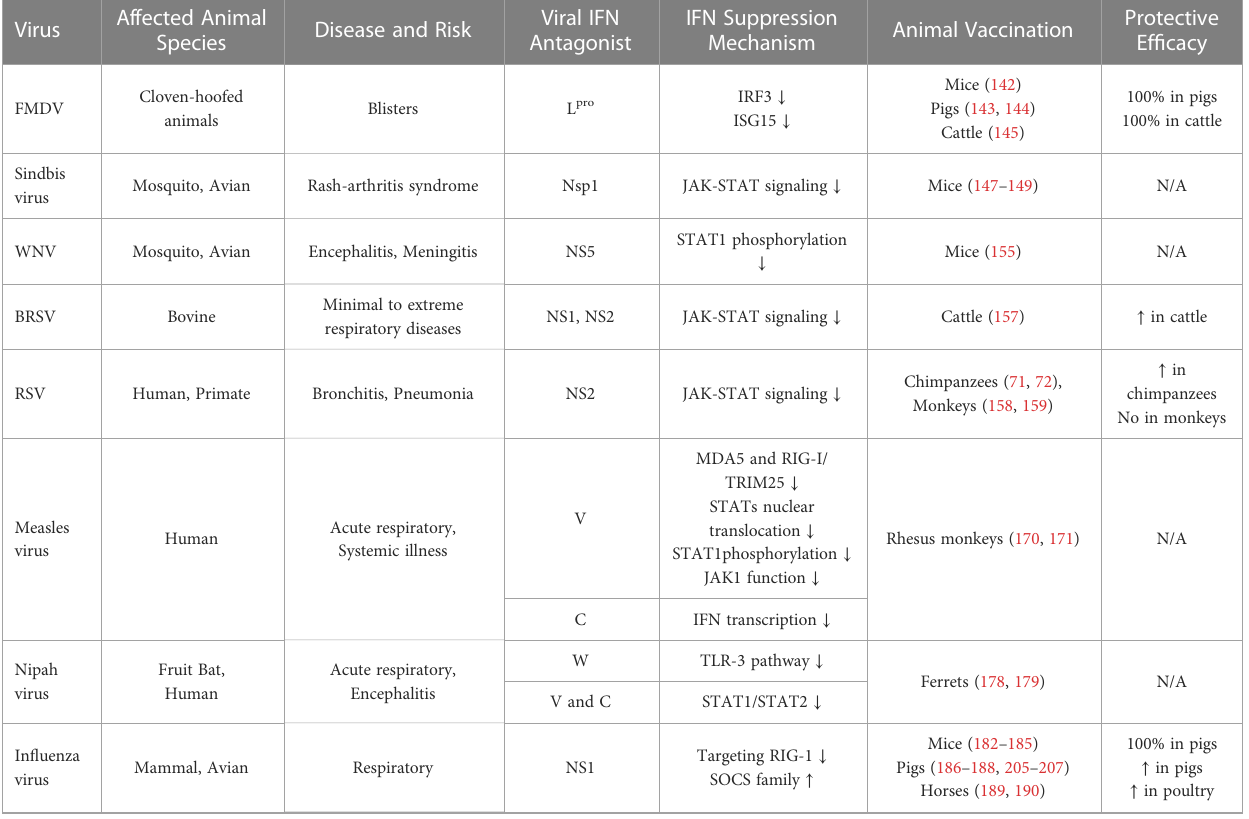
TABLE 1 The reprogramming of mutant viruses that their IFN evasion functions were eliminated by reverse genetics and the protective ef fi cacies in natural host animal species following vaccination and virulent challenges.